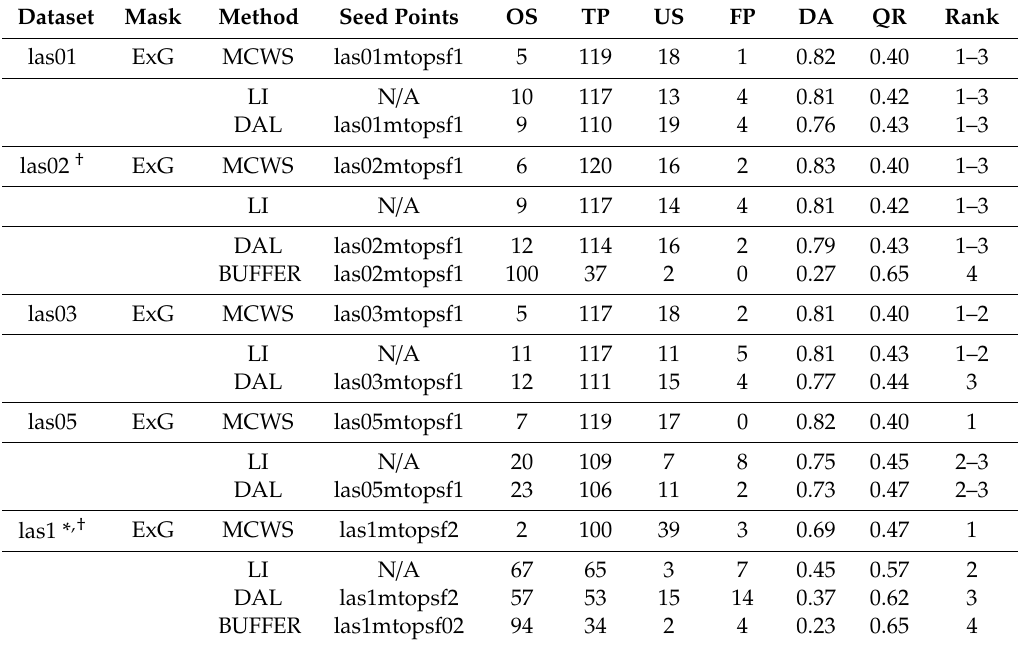
Table 9. The accuracy of automatic ITCD applied to tested PPCs with the di ff erent point